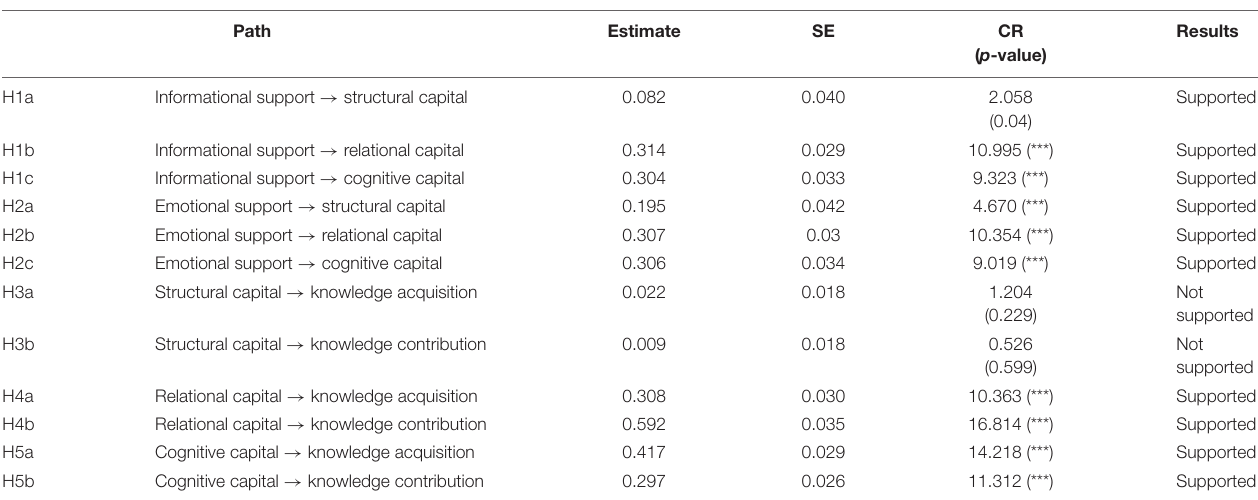
TABLE 5 | Results of the hypotheses